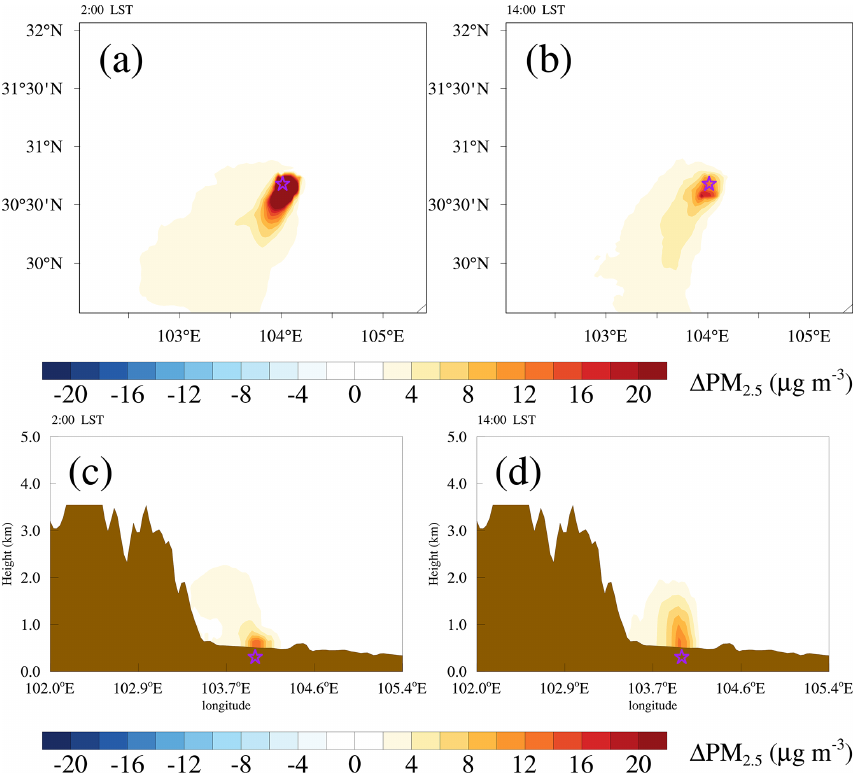
Figure 11. Same as Fig. 9 but for the difference between the monthly average of the Jan_Base and Jan_noEmi simulations (Jan_Base minus